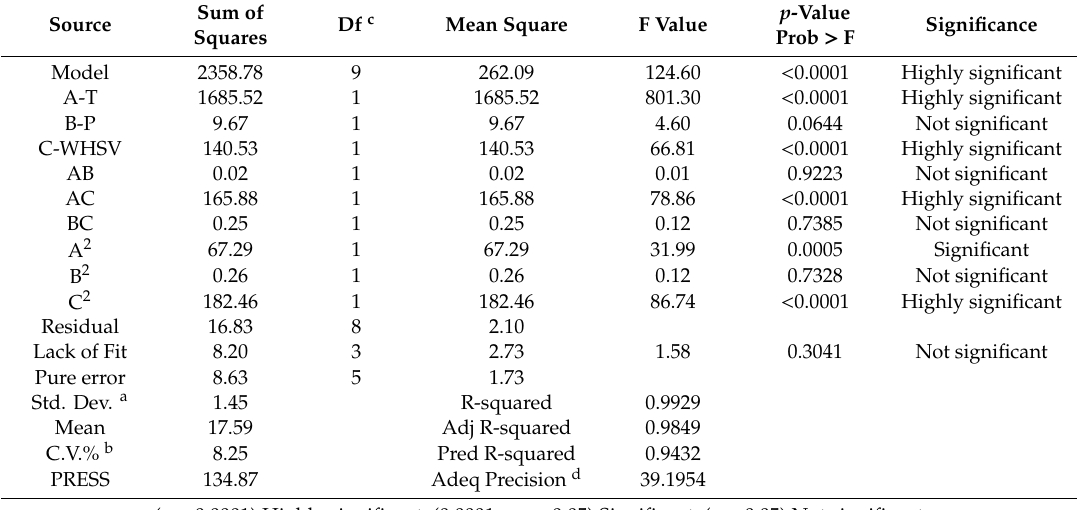
Table 3. Analysis of variance for the BTEX experimental